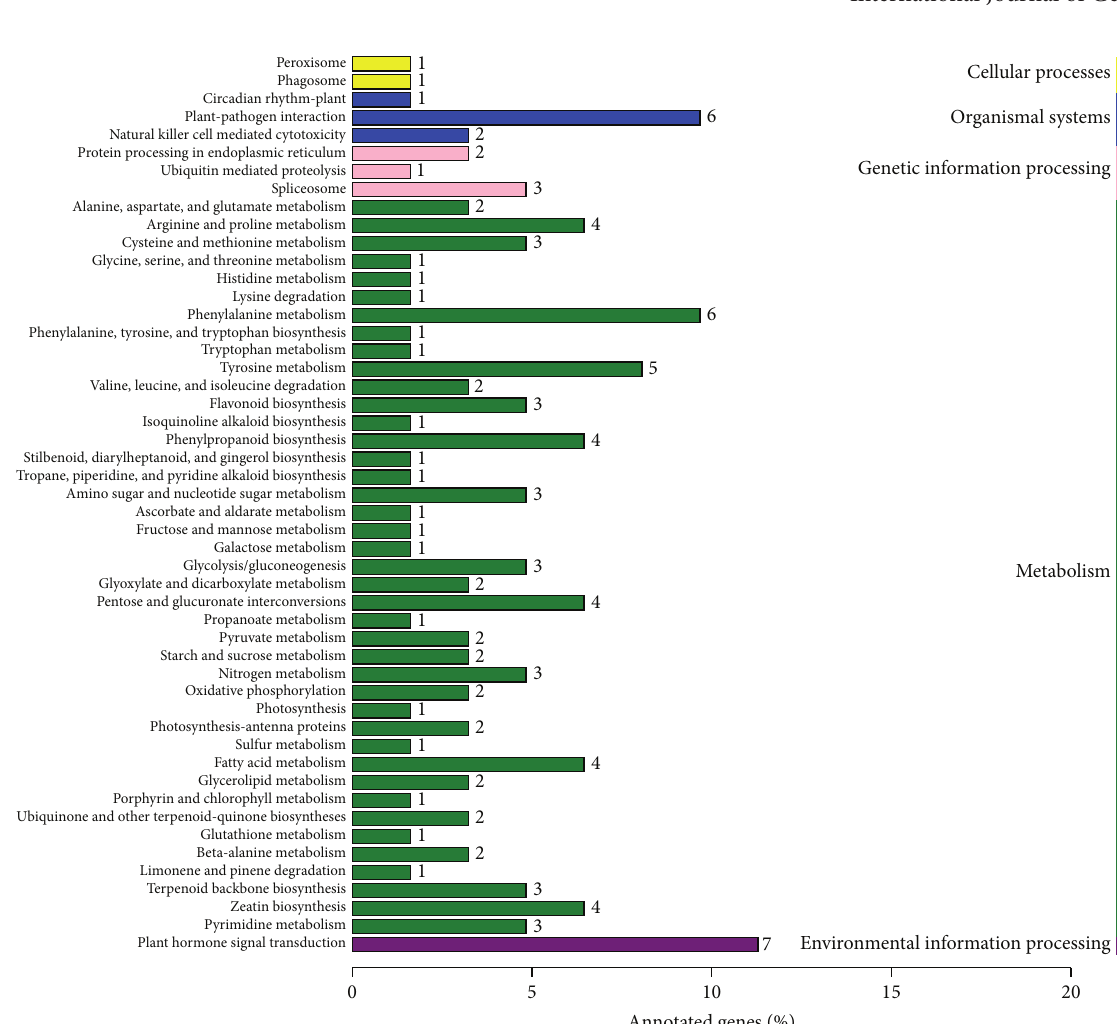
Figure 6: KEGG-based functional classification of DEGs between Weiduoli and HVB-3. Numbers beside each bar represent the actual number of DEGs classified in that descriptive